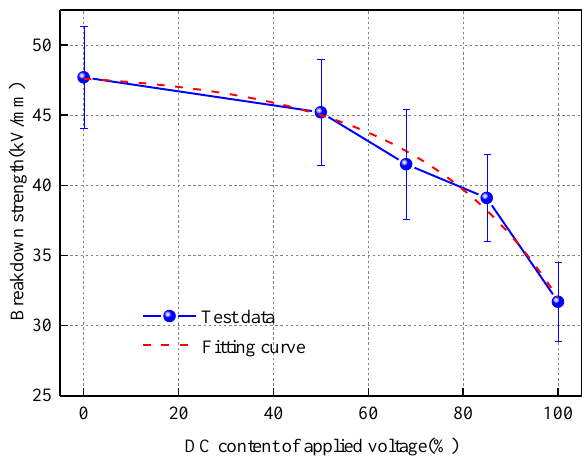
Figure 4. Breakdown strength of transformer oil under AC-DC combined voltage.